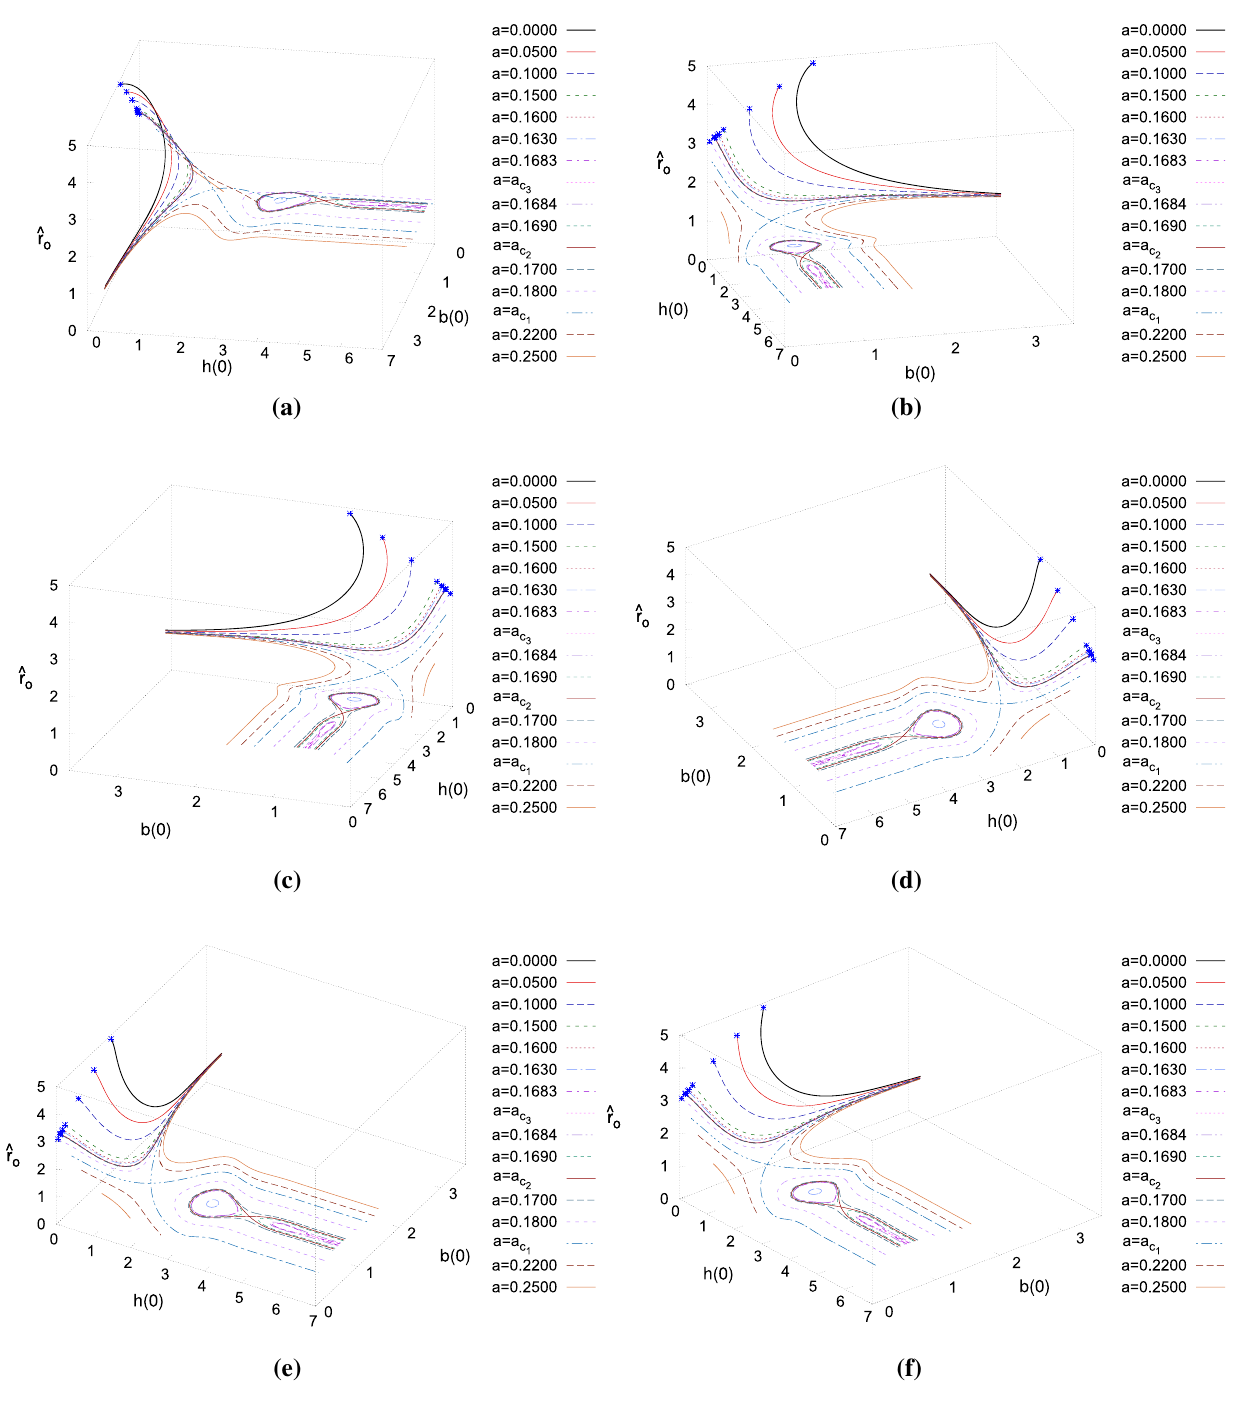
Fig. 4 a – f The 3D phase diagram (for different viewing angles) of h ( 0 ) and b ( 0 ) versus ˆ r o for a set of values of a in the range a = 0 . 0 to a = 0 . 2500. The viewing angles are denoted by (θ,φ) , where θ is the angle of rotation about the ox -axis in the anticlockwise direction,